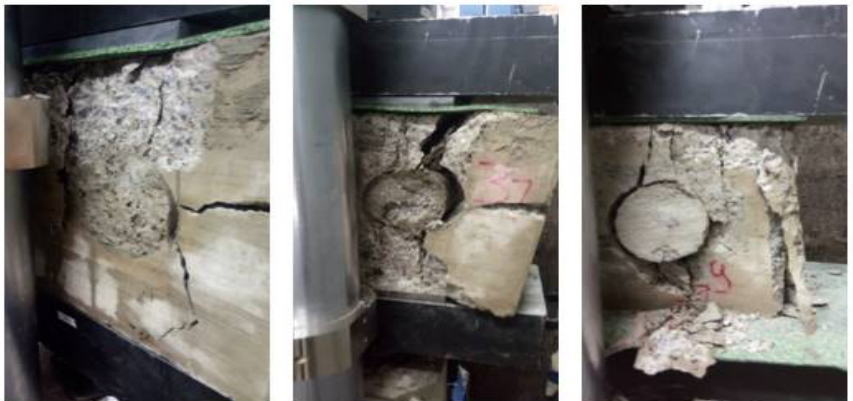
Figure 8 – Fracture characteristics of each repaired block (left to right: C20, grout and dry